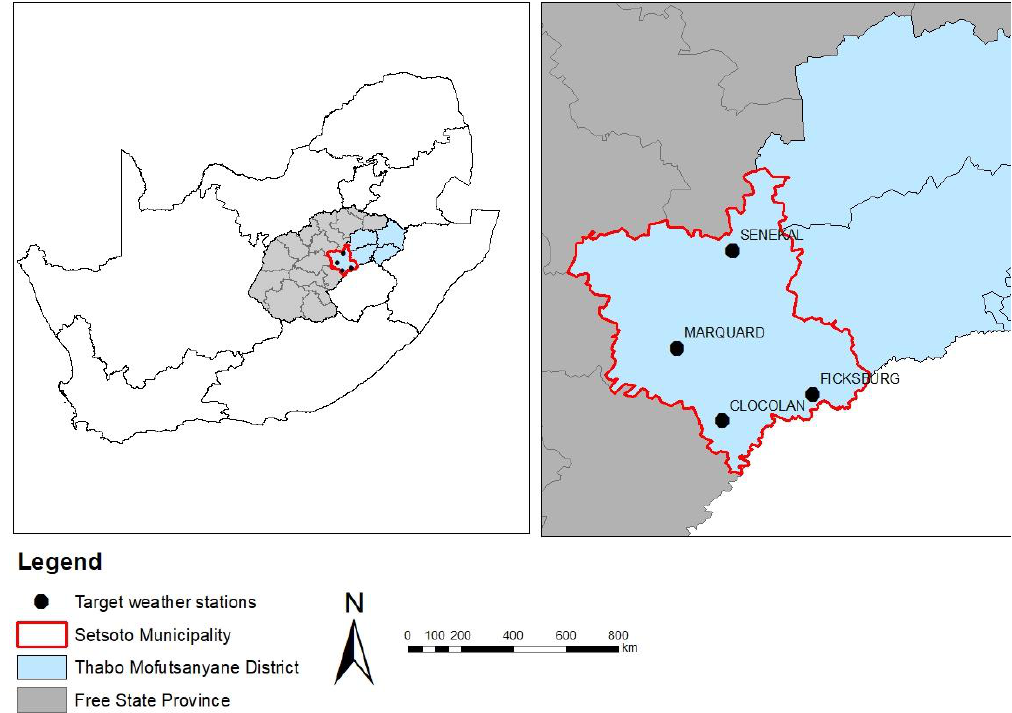
Figure 1. Map of the Free State province of South Africa showing the locations of the study area, the Setsoto Municipality and the target weather stations.